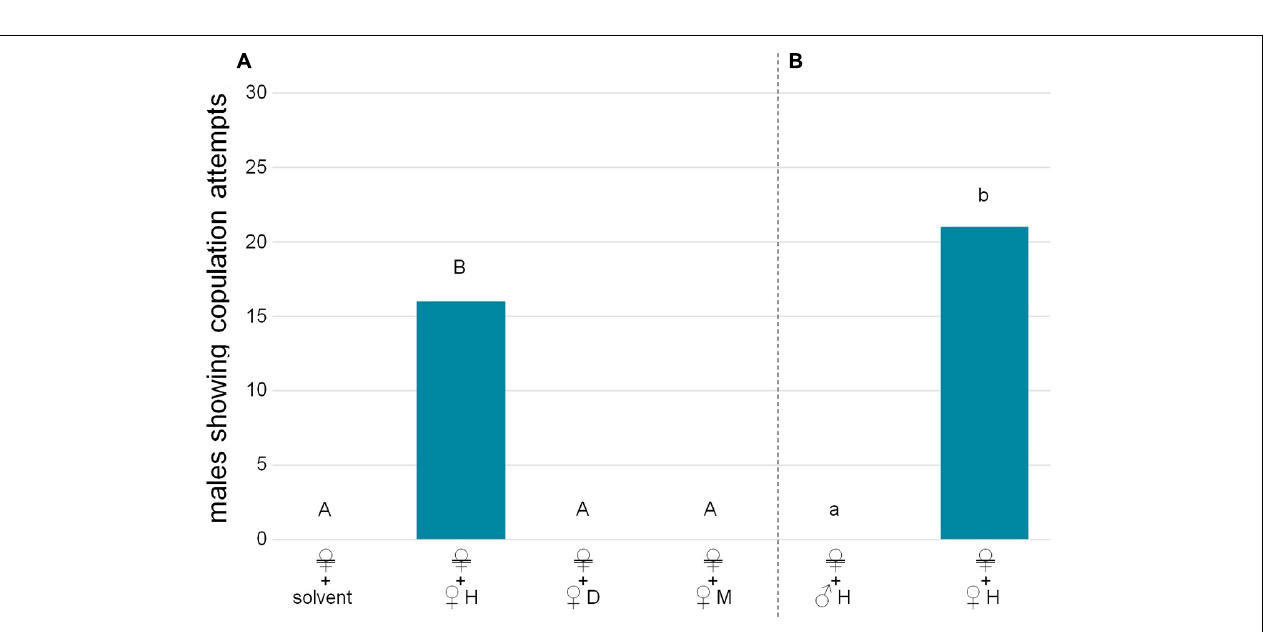
FIGURE 3 | Bioactivity of female-derived extract fractions. Female-derived extracts were applied to a silica gel cartridge and eluted with hexane (H, non-polar fraction containing hydrocarbons), dichloromethane (D, fraction containing lipids of low to medium polarity) and methanol (M, fraction containing lipids of higher polarity). (A) Males were confronted with Soxhlet-extracted females treated either with a solvent control or a female-derived extract fraction (H, D, or M, two female equivalents). (B) As the H fraction was the only fraction bioactive on its own, males were confronted with Soxhlet-extracted females treated with the H fraction of either male-derived extracts or of female-derived extracts (amounts equivalent to two individuals). Significant differences in male reactions are depicted by different letters [ χ 2 tests, (A) with Bonferroni-Holm correction, capital letters, (B) lower case letters. In all significant cases p < 0.001, n = 30 each].